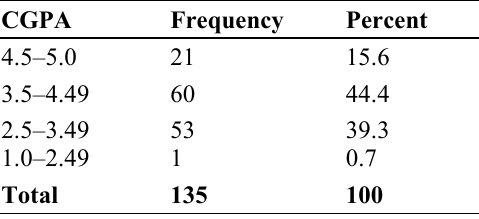
Table 6. The Frequency of Occupants’ Cumulative Grade Point Average before Moving to the University Hostel CGPA